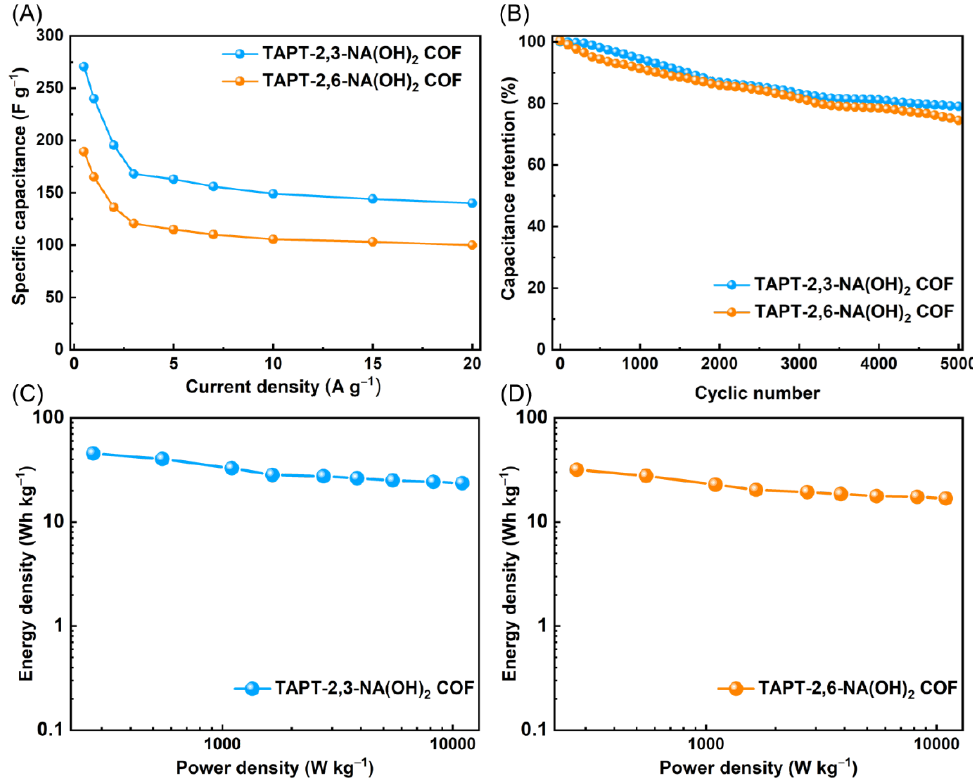
Figure 6. ( A ) Calculated specific capacitances of TAPT-2,3-NA(OH) 2 and TAPT-2,6-NA(OH) 2 COFs, measured at different current densities (A g −1 ). ( B ) Cycling performance of TAPT-2,3-NA(OH) 2 and TAPT-2,6-NA(OH) 2 COFs, measured at current density of 10 A g −1 . ( C , D ) Ragone plot showing the energy density and power density for the ( C ) TAPT-2,3-NA(OH) 2 and ( D ) TAPT-2,6-NA(OH) 2 COFs electrodes.